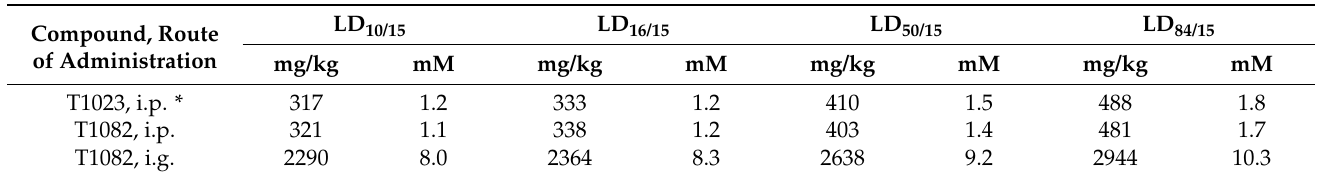
Table 1. Indicators of T1082 and T1023 acute toxicity for outbred mice after a single intraperitoneal and intragastric